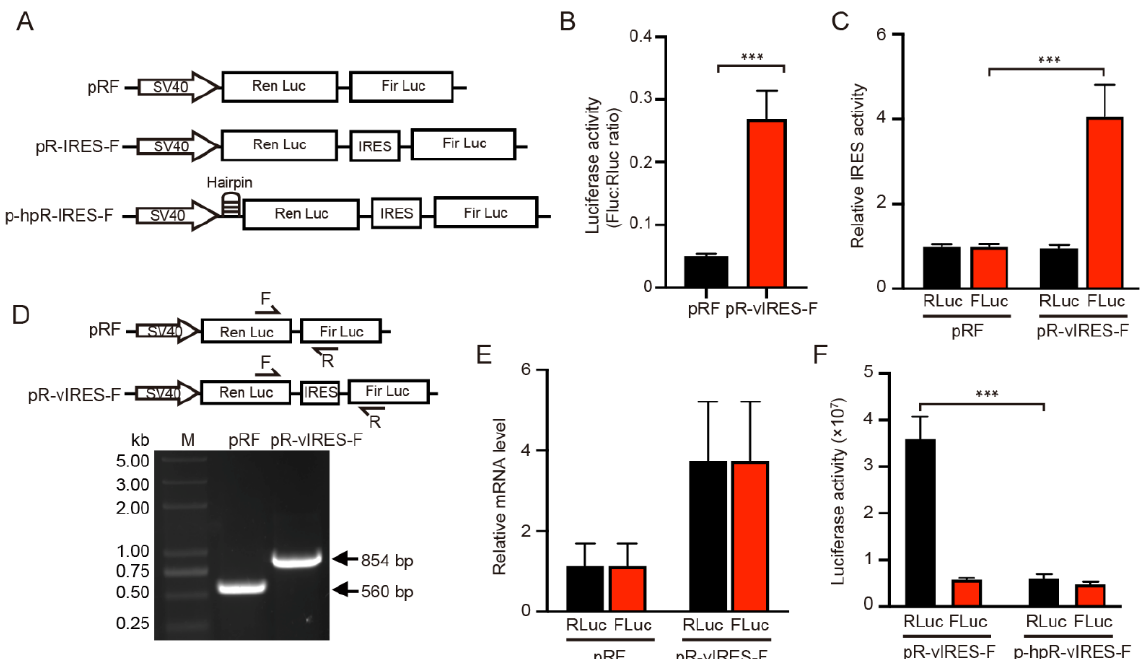
Figure 1. Dual luciferase assay for the functional analysis of VEGFA IRES-A (vIRES). ( A ) Schematic illustration of the dicistronic reporter gene vector constructs used in this study. ( B , C ) Influence of vIRES positioned upstream the firefly and renilla luciferases. The IRES activity are represented as ratios of firefly to renilla luciferase. The individual luciferase activity was normalized to that of the control vector pRF. ( D ) RT-PCR and ( E ) qRT-PCR verification of the influence of vIRES on the mRNA splicing and transcription. ( F ) Activity of the individual luciferases in the bicistronic vectors in the absence or presence of a hairpin upstream of renilla luciferase. *** indicates significant difference at p <